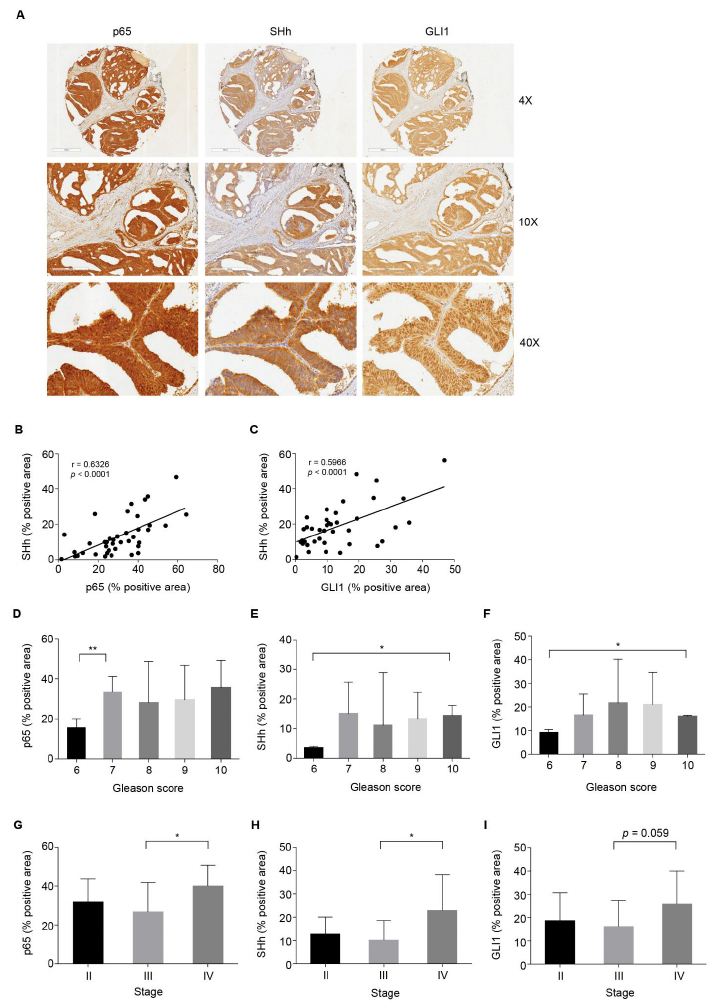
Figure 2. NF- κ B-p65 high expression correlates with SHh and GLI1 expression in PCa. ( A – I ) IHC analy- sis for p65, SHh and GLI1 on PCa tissue array (TMA). ( A ) Images of IHC staining of the